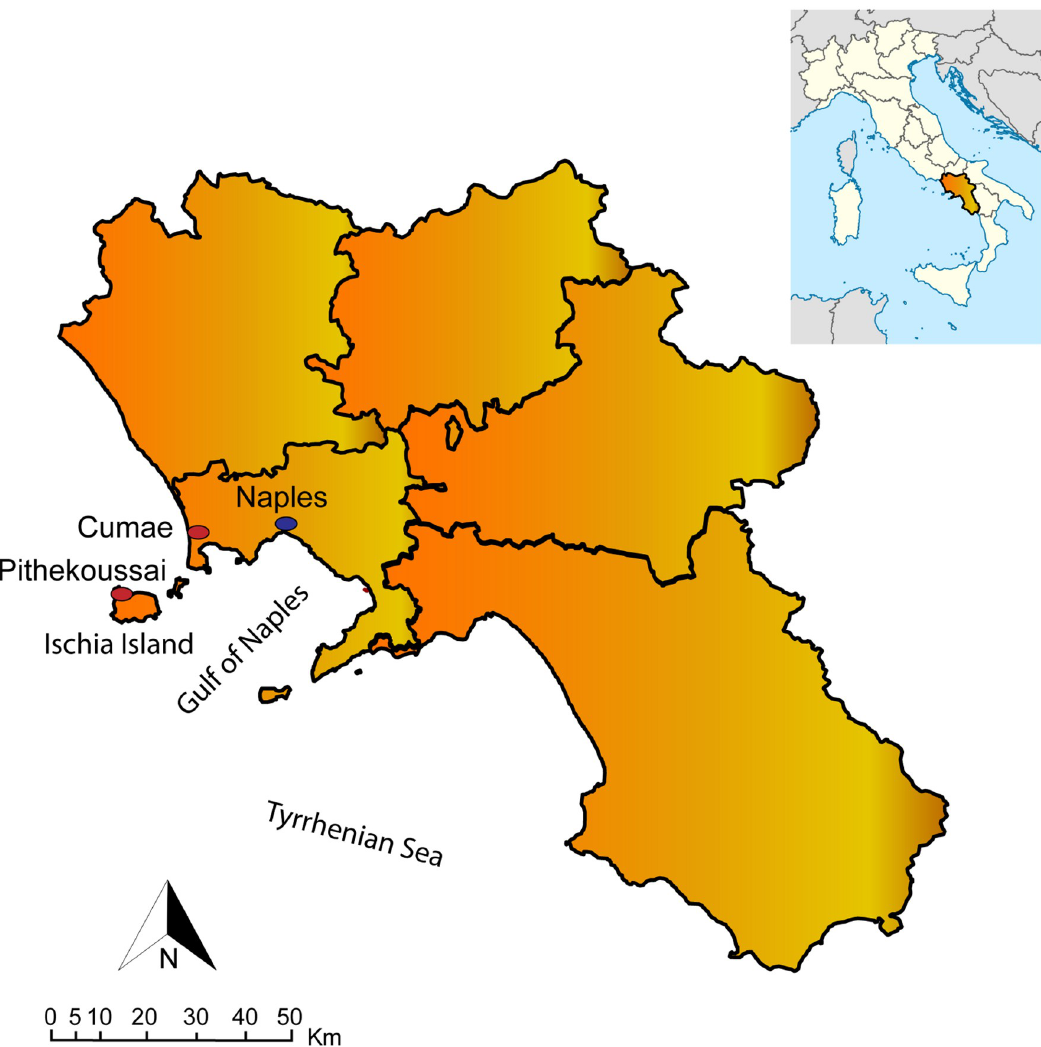
Fig 1. Pithekoussai, current Ischia Island, the major Island of the Phlegrean district, in the Gulf of Naples, in the Campania region (South Italy). On the mainland, the cities of Naples and